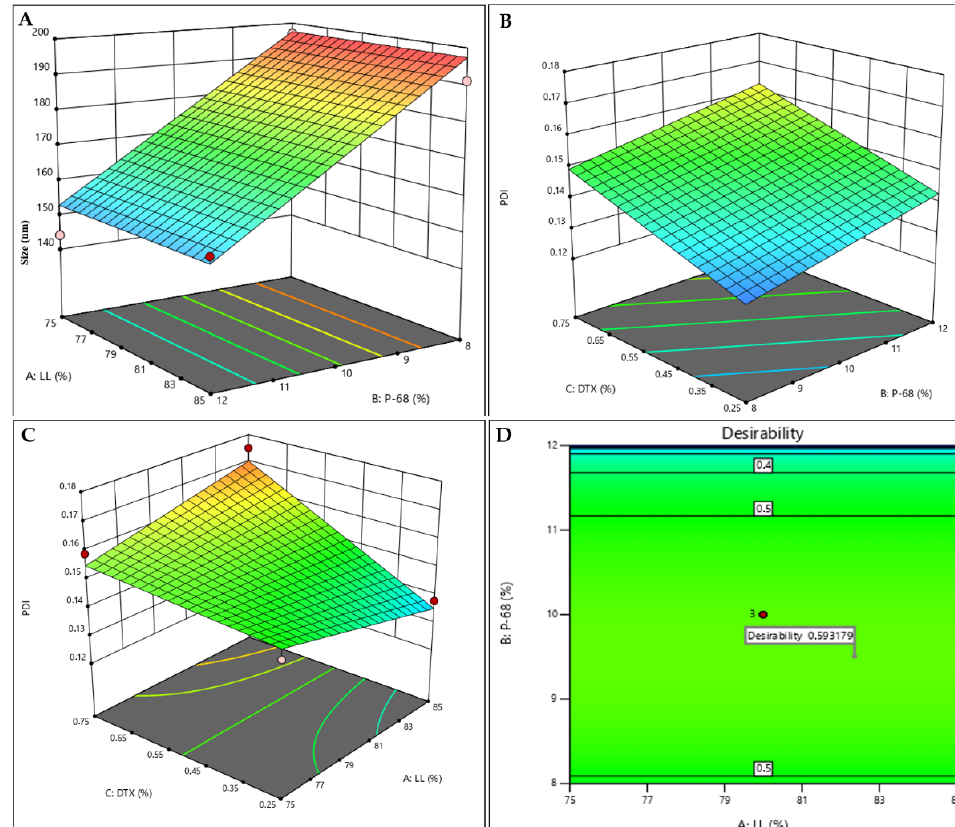
Figure 2. Factorial design results for the NLC DTX system: response surfaces for size ( A ), PDI ( B , C ), and desirability graph ( D ).